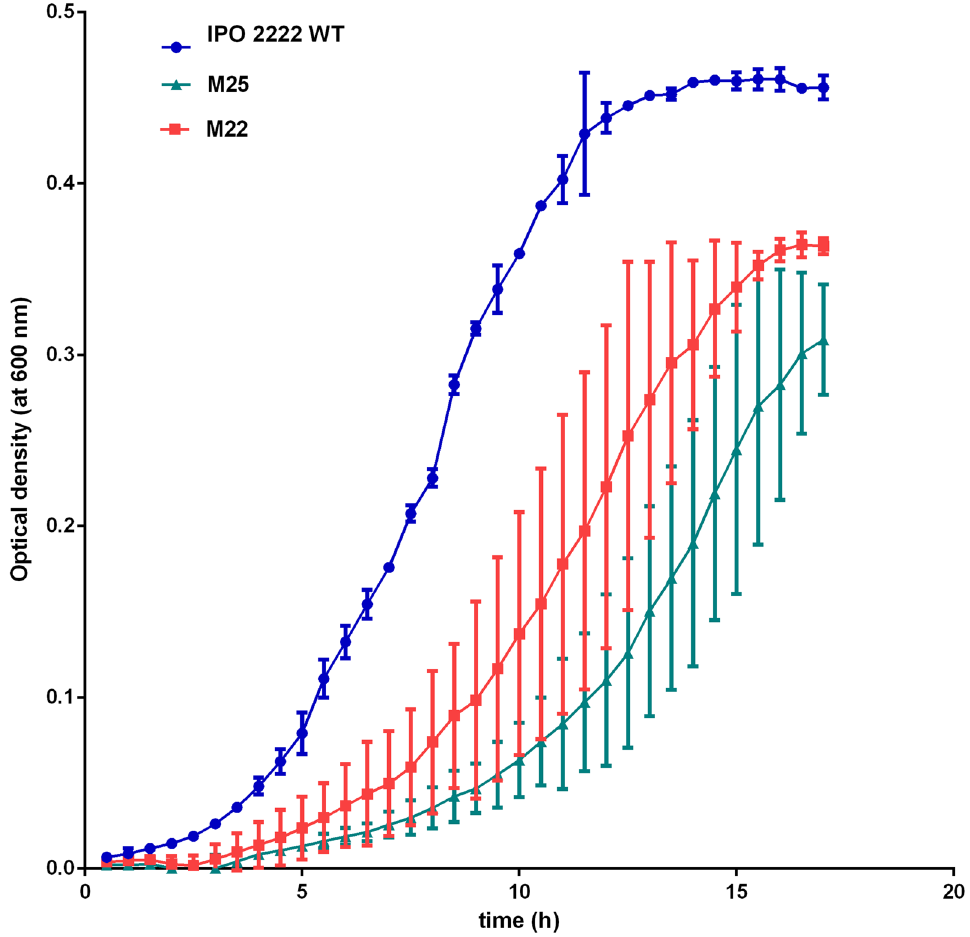
Figure 4. Growth of D. solani WT and phage-resistant mutants M22 and M25 in minimal growth medium (M9 + 0.4% glucose). The experiment was performed in two biological replicates containing two technical replicates each (n = 4). The results were averaged for presentation. The bars show standard deviation